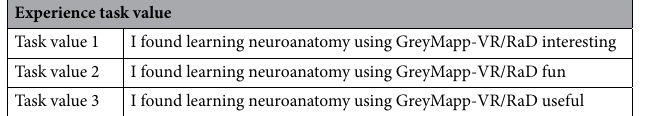
Table 1. Questions to measure the experienced task value. Adapted from (Pintrich, 1991) 64 .